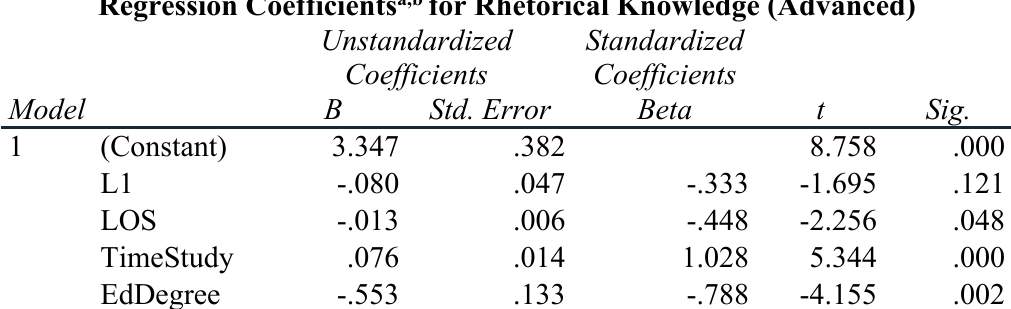
Regression Coefficients a,b for Rhetorical Knowledge